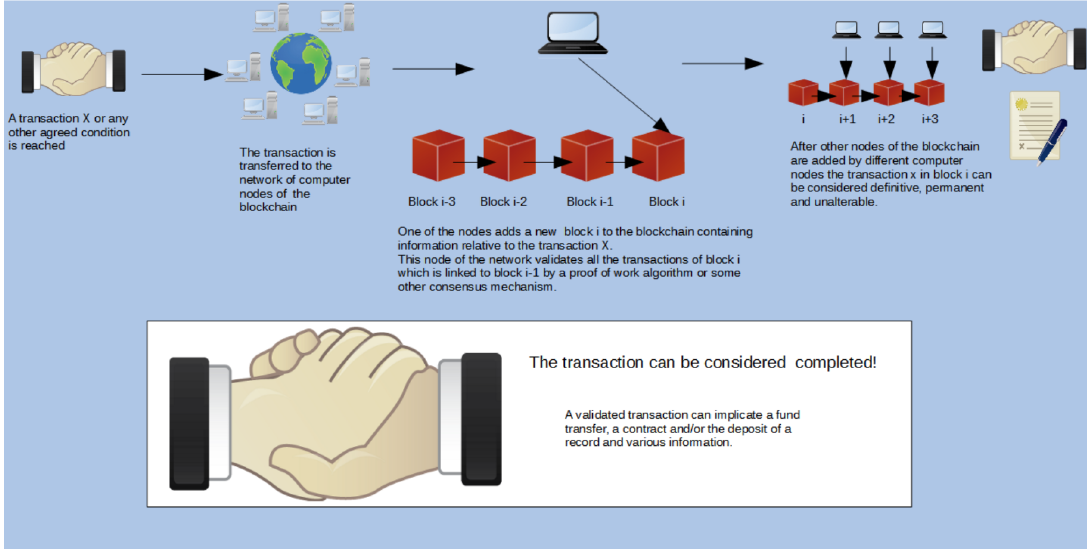
Figure 1. The blockchain made